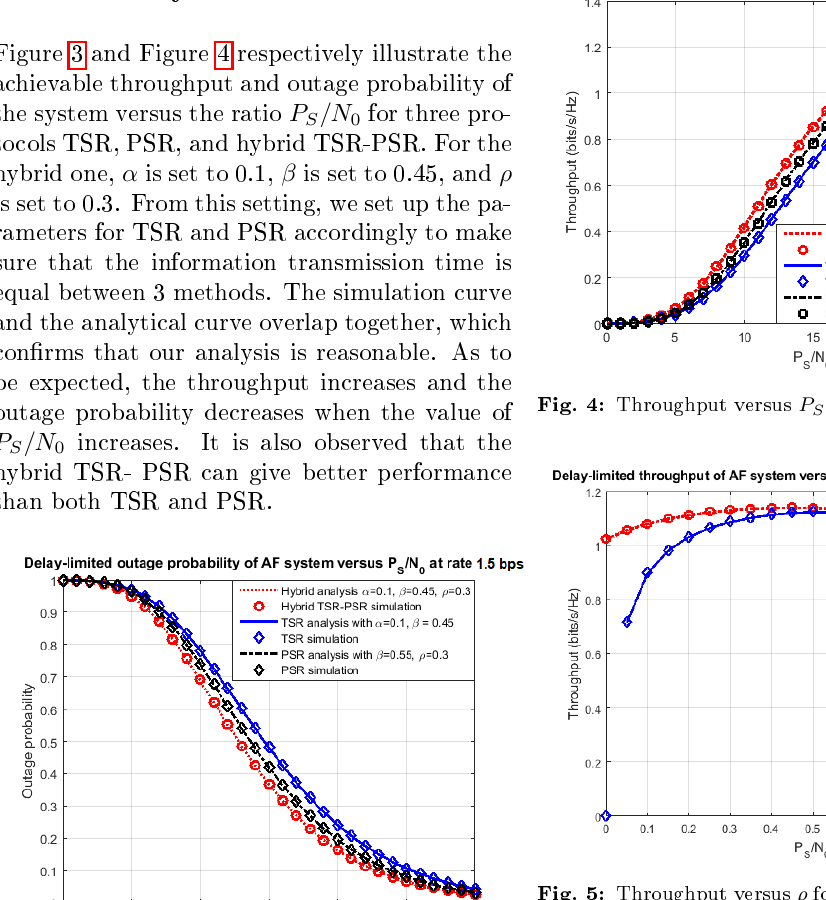
Fig. 5: Throughput versus ρ for hybrid and PSR proto-